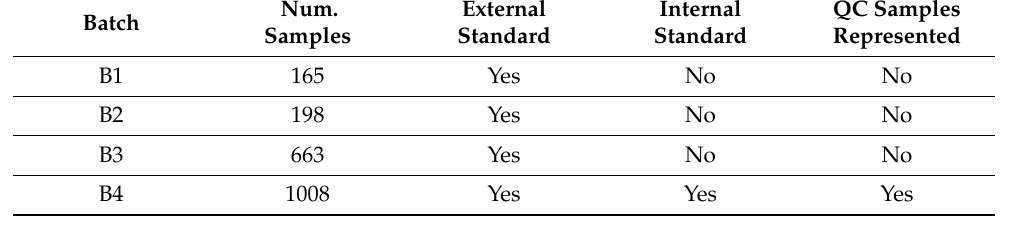
Table 1. Summary of samples per batch, type of standard included, and whether QC samples were represented or not. Num. Batch